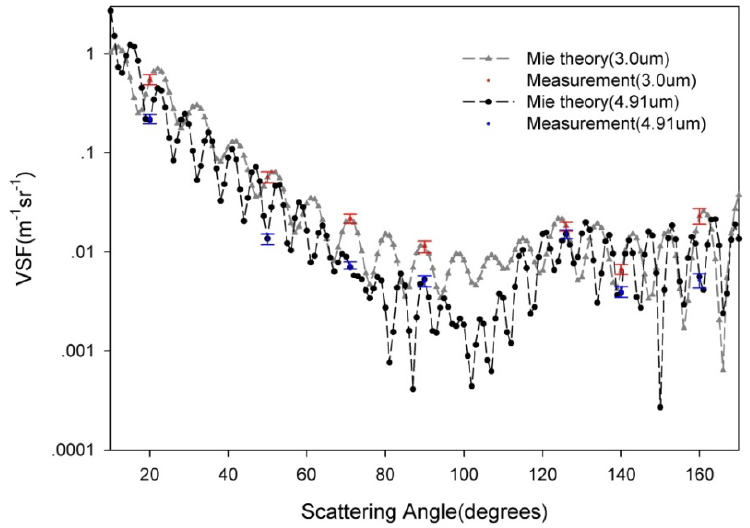
Figure 10. Comparison of theoretical Mie calculations and direct measurements of